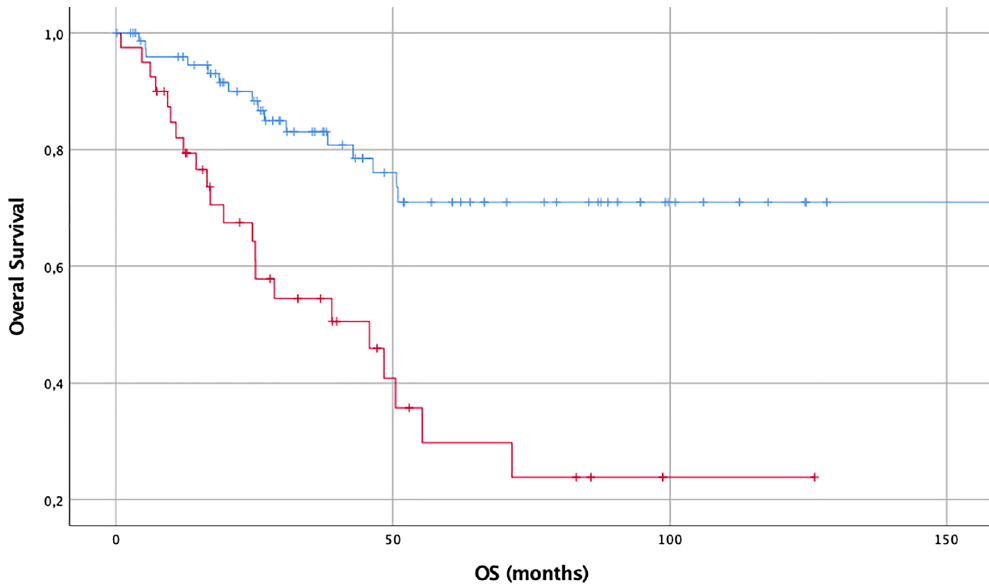
Figure 5. OS (months) in diffuse and anaplastic gliomas considering expression of actin: no or slight expression (blue, n = 78) vs. intermediate or strong expression (red, n = 39), demonstrating worse survival for tumors with higher actin